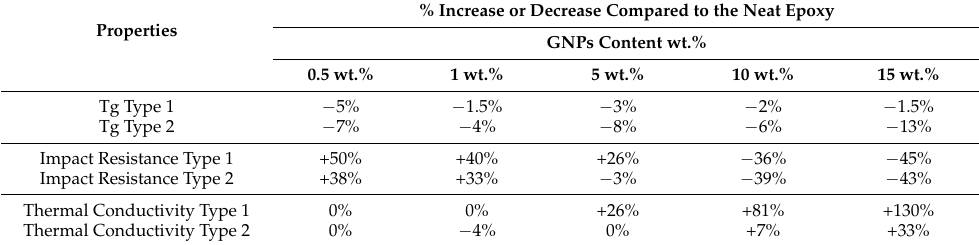
Table 1. Comparative results for the tested materials.